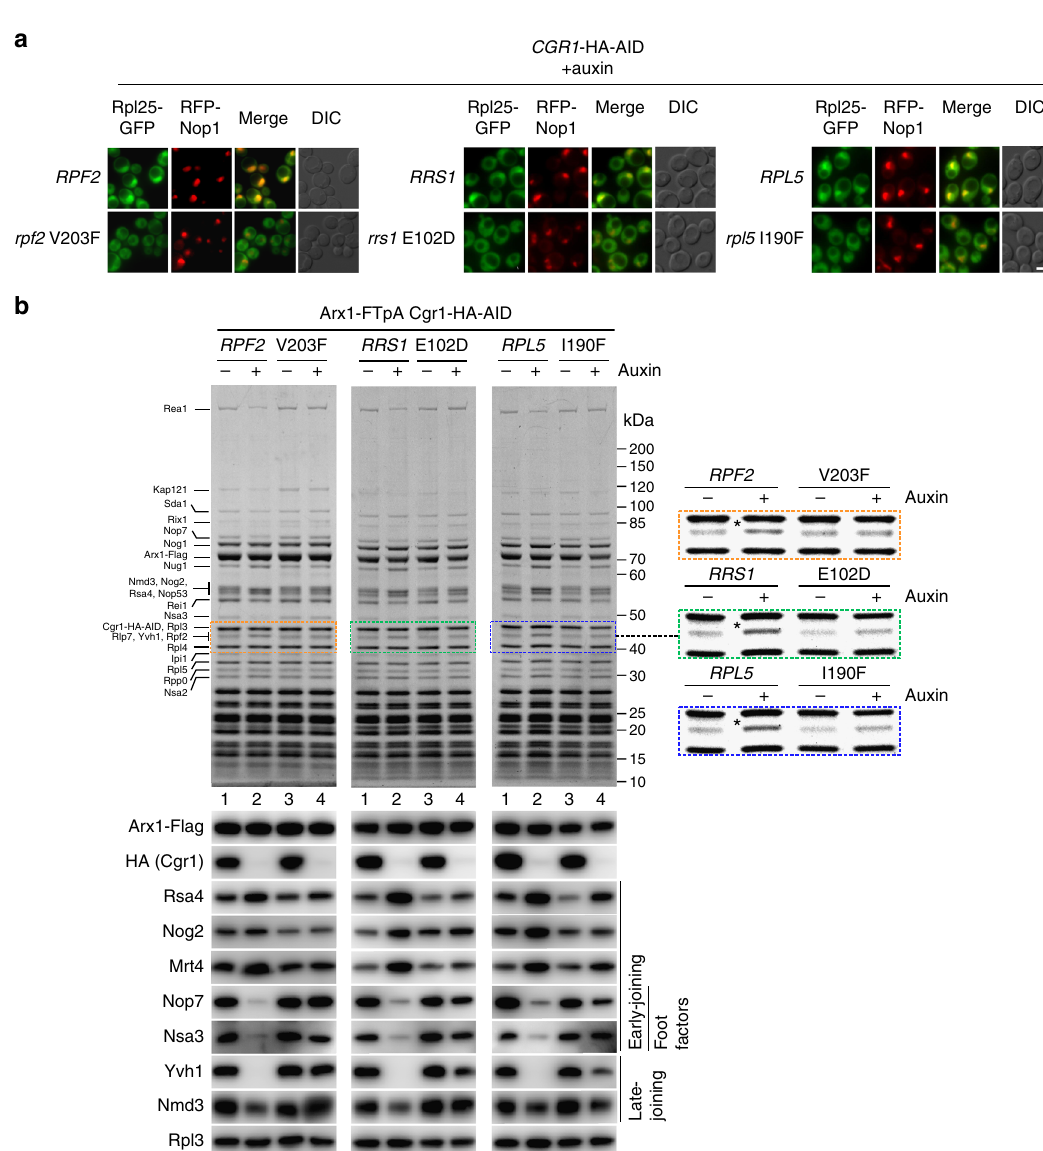
Fig. 5 Suppressor mutations in Rpf2, Rrs1 and Rpl5 rescue the 60S biogenesis defect in Cgr1-depleted cells. a Nuclear pre-60S export is restored in suppressor mutants after Cgr1 depletion. Subcellular location of Rpl25 – GFP and RFP – Nop1 (nucleolar marker) was examined in CGR1 – HA – AID cells expressing either wild-type RPF2 , RRS1 and RPL5 or the respective mutant alleles rpf2 V203F, rrs1 E102D and rpl5 I190F, after incubation with auxin for